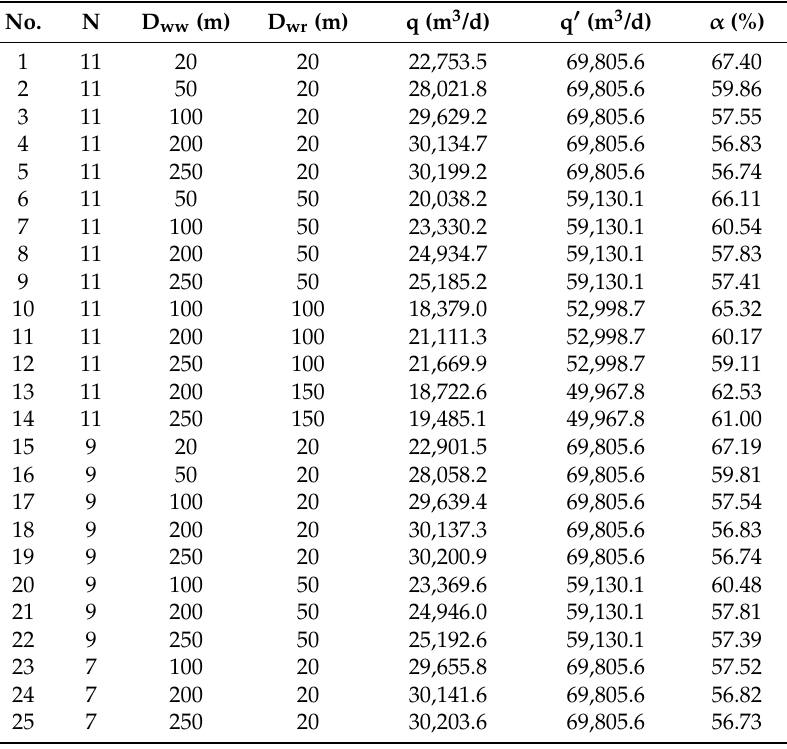
Table 2. Interference coefficient of